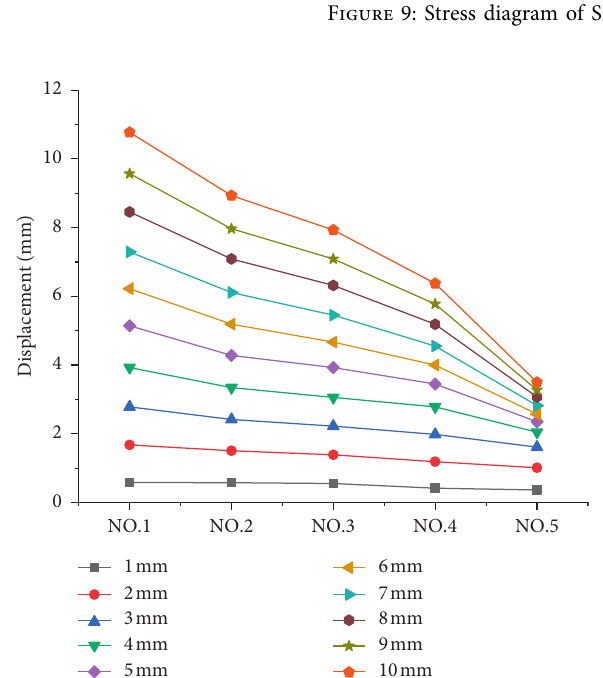
Figure 10: Displacement variation of displacement measuring point (No. 1 ～ No. 5).